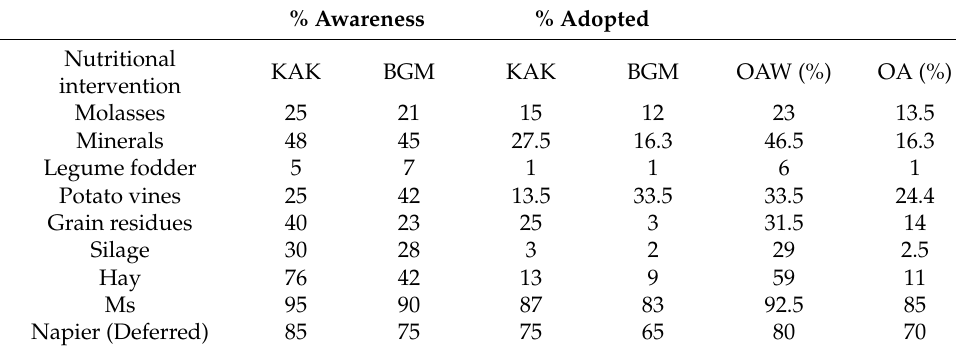
Table 3. Nutritional interventions practiced by farmers, Kakamega and Bungoma Counties, Kenya. %